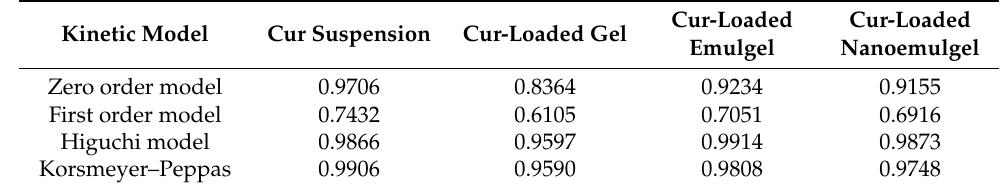
Table 3. Release kinetics of different Cur-loaded formulations.